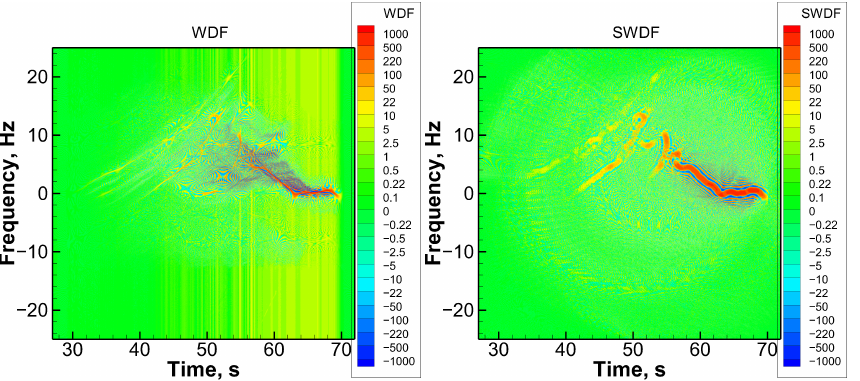
Figure 12. COSMIC-2 rising RO event observed on 15 May 2020 UTC 20:42, 24.36 ◦ S 14.18 ◦ E. Left: WDF, right: